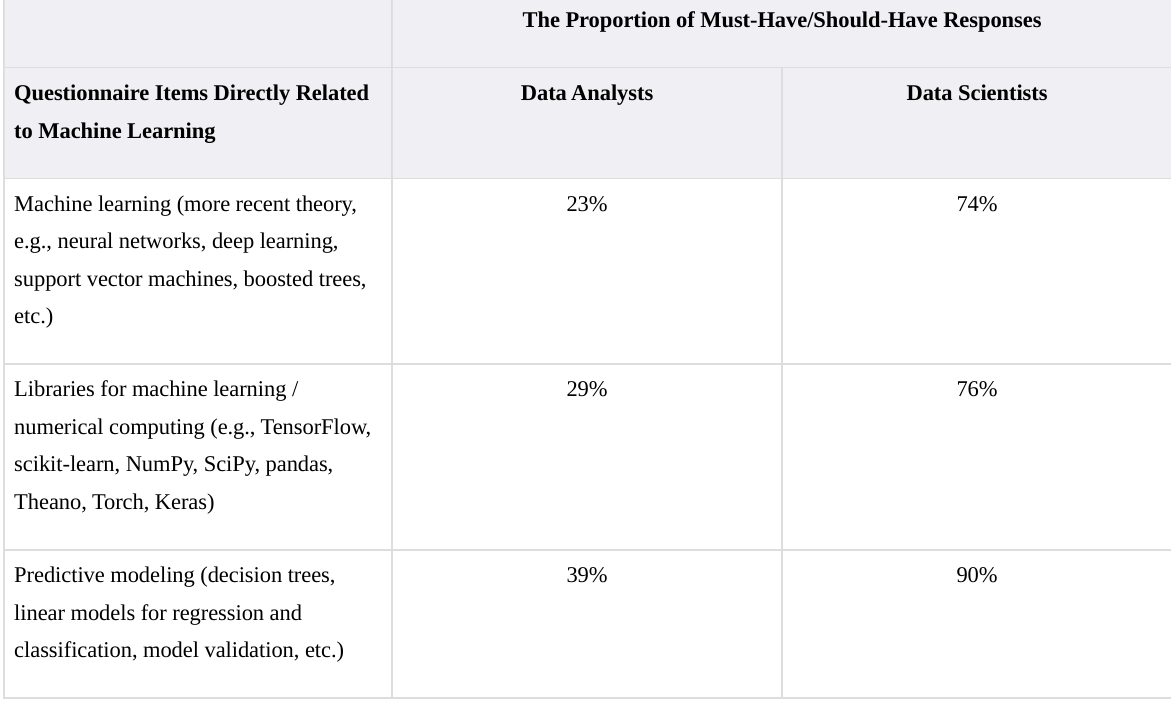
Table 4. Proportion of must-have/should-have responses to the questionnaire items related to machine learning by data analysts and data